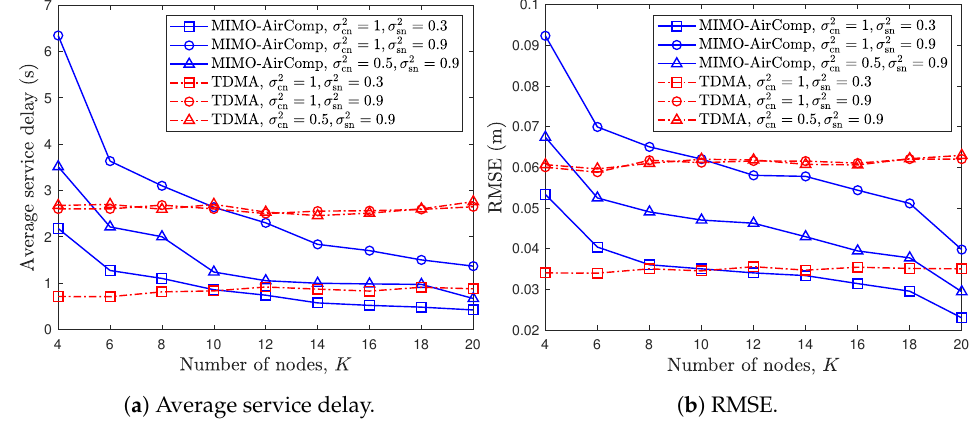
Figure 3. Average service delay and RMSE of the MIMO-AirComp and TDMA with different parameters σ 2 cn = 0.5,1 and σ 2 sn = 0.3,0.9 for various numbers of beacon nodes K = 4, . . .